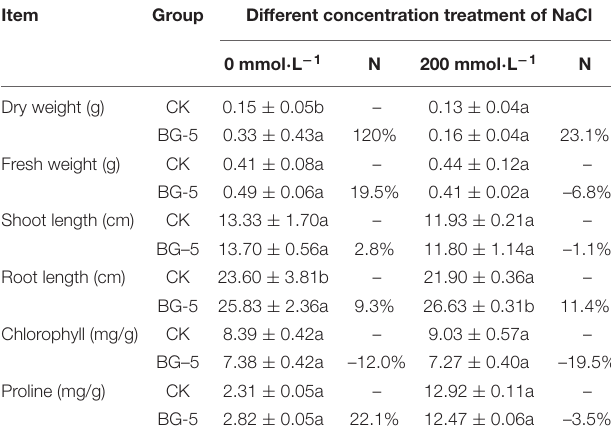
TABLE 5 | The effects of BG-5 strain on wheat growth under 0 and 200 mmol · L − 1 NaCl treatments.